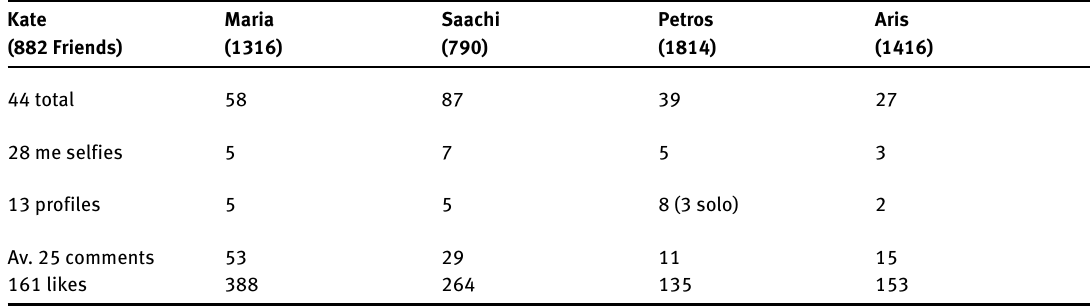
Table 1: Data-set of selfies posted on FB (March 2014-March 2015)